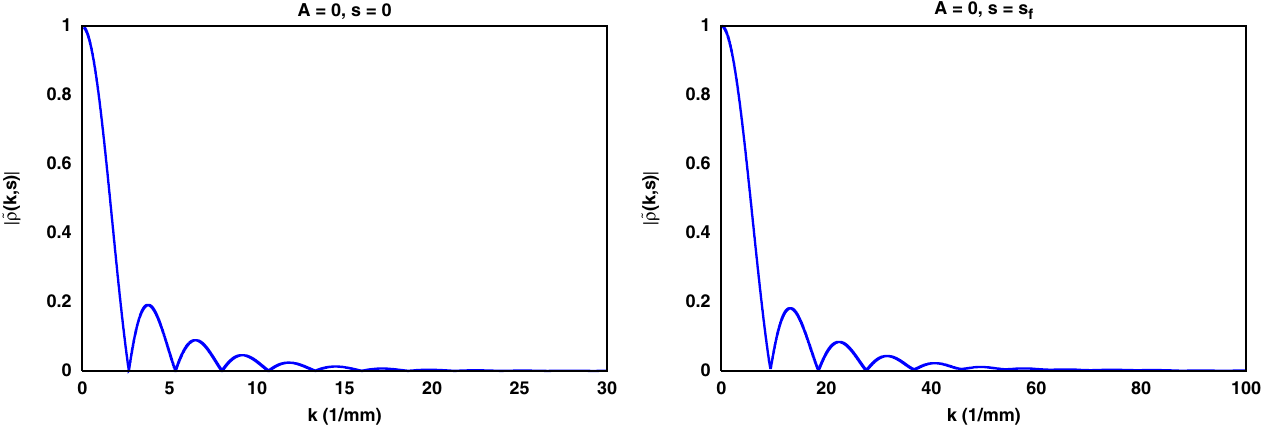
with self-fields. f